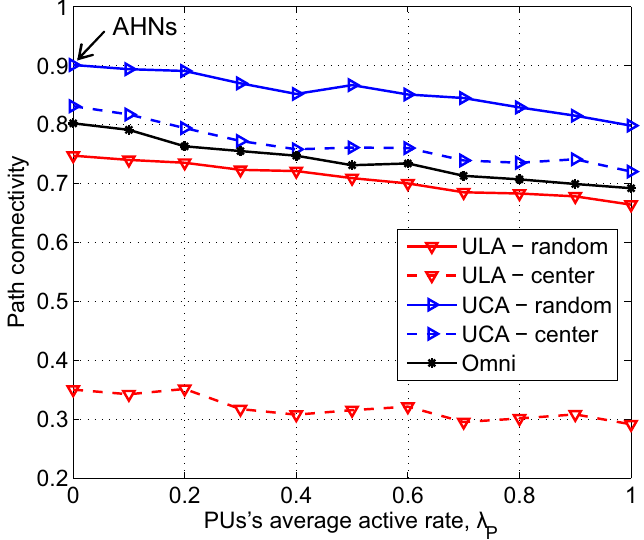
Figure 8. Path connectivity corresponding to different kinds of antennas and beamforming schemes as a function of the average active rate of PU; a = 500 m, M = 6, N S = 200, N P = 3, α = 3, γ th = 50